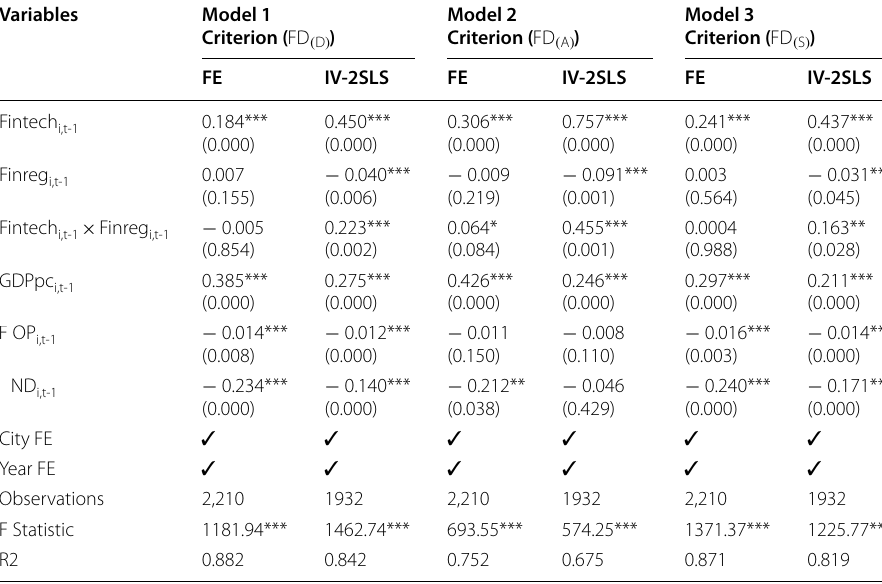
Table 4 Influence of fintech on dimensions of financial development